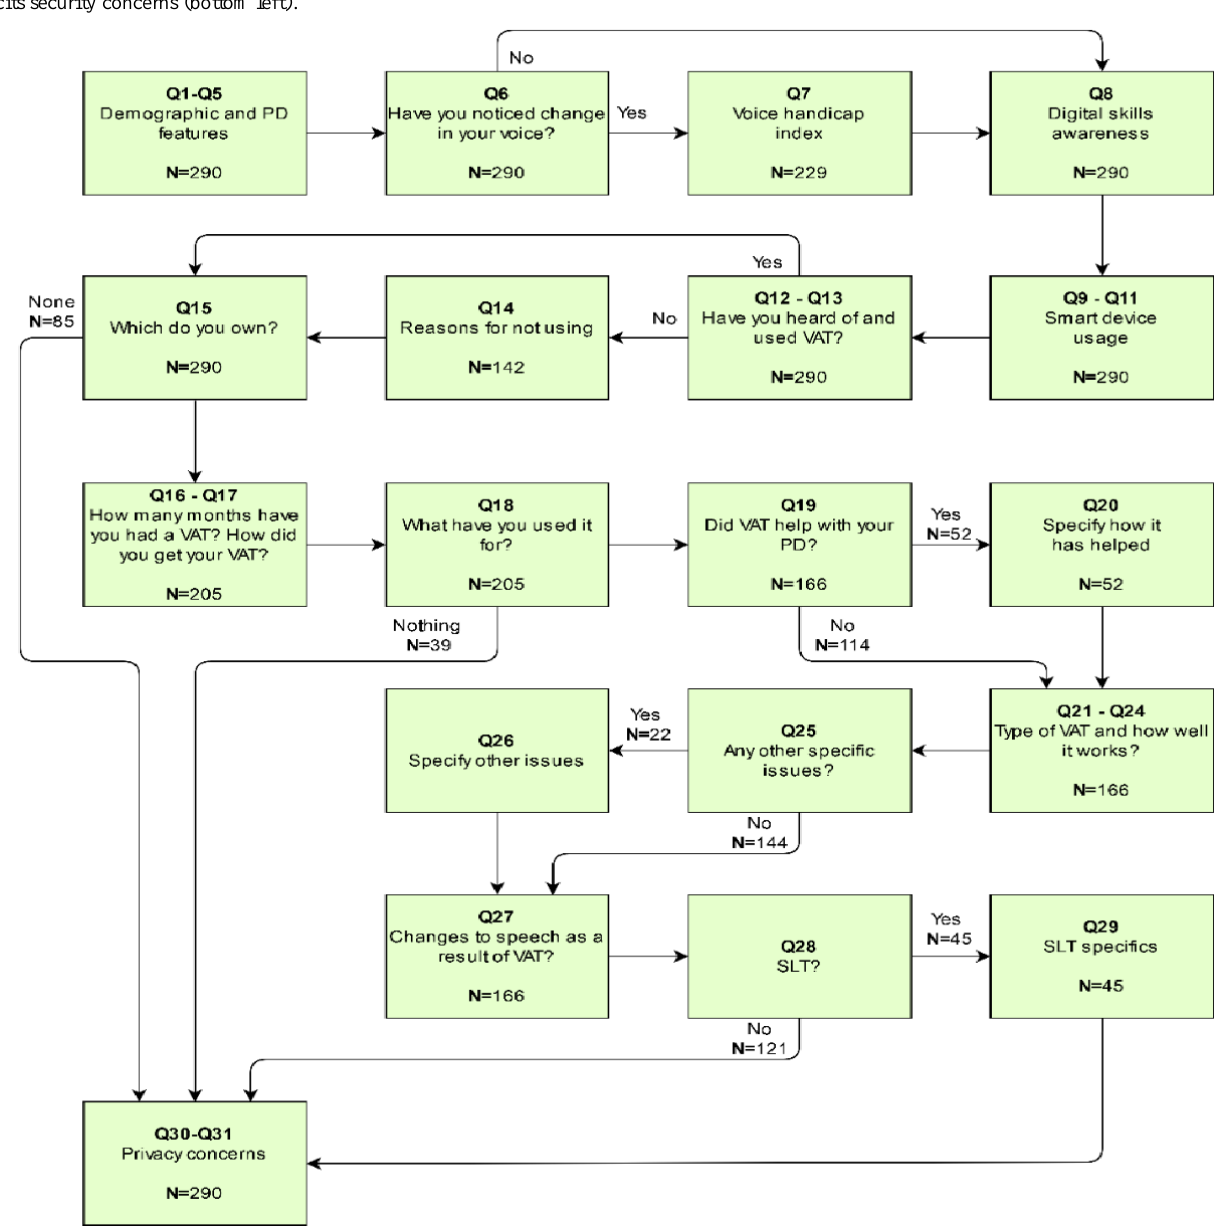
Figure 1. Survey flow diagram. Starting at top left, the diagram shows elements of the survey with skip logic to avoid unnecessary questions such as Voice Handicap Index, which applies to respondents who notice a change (Q7). Numbers of respondents to each element are given. The final element elicits security concerns (bottom